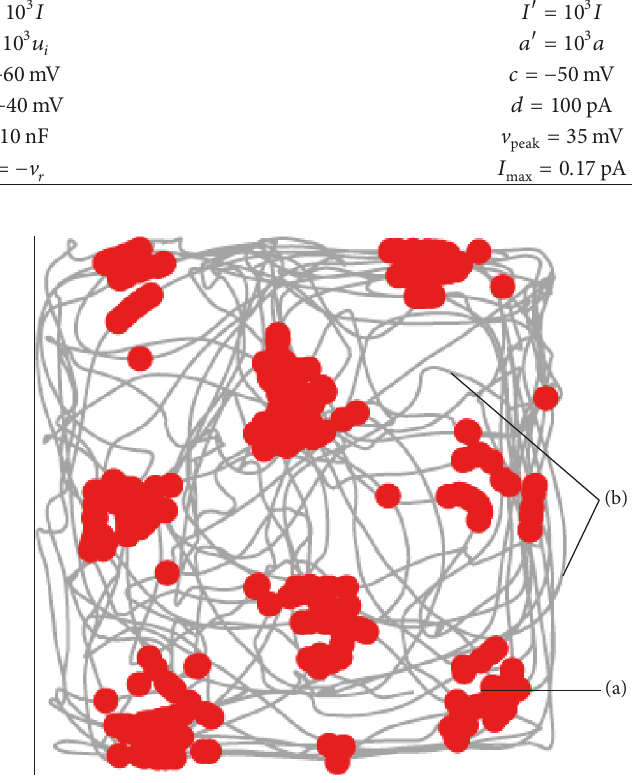
Figure 1: Grid cells in the MEC of a rat while moving in an arena (from [5]): (a) set of spikes (in red) that appears while the rat is moving around certain locations, (b) random walk trajectories in